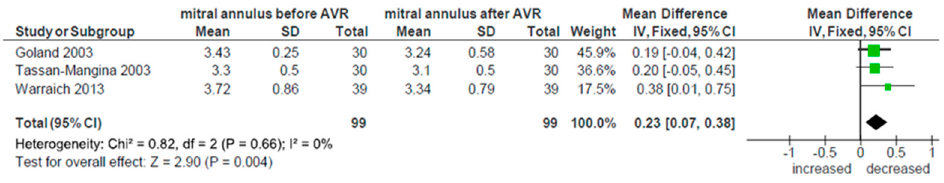
Figure 7. Mitral annulus diameter change after AVR.